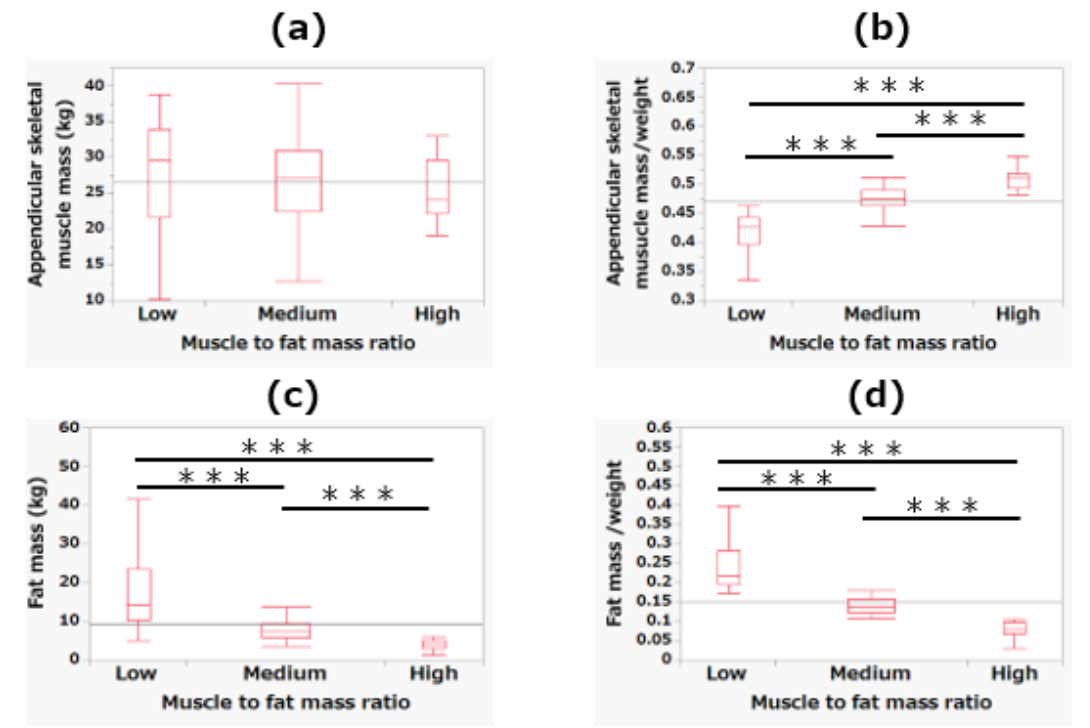
Figure 2. The differences among the tertiles of skeletal muscle-to-fat mass ratio in skeletal muscle mass ( a ), skeletal muscle mass/weight ( b ), fat mass ( c ), and fat mass/weight ( d ). *** p < 0.001.